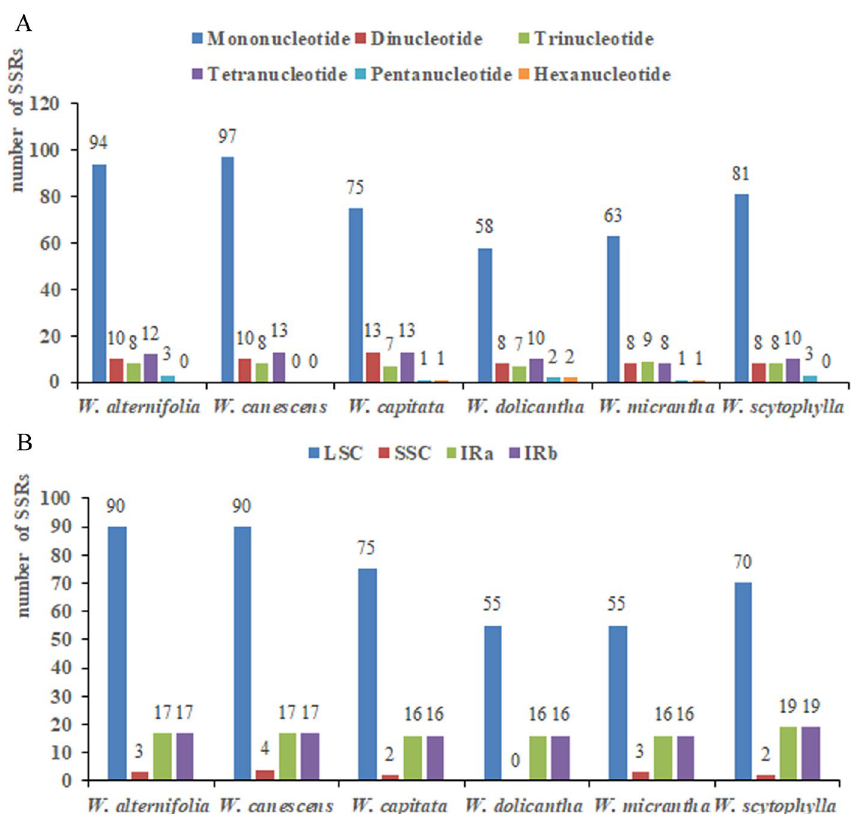
Figure 2. Distribution of small sequence repeats (SSRs) in the plastomes of six accessions of Wikstroemia . ( A ) Number of different SSR types detected in the plastomes of six species of Wikstroemia ; ( B ) Frequencies of identified SSRs in large single-copy (LSC), small single-copy (SSC) and inverted repeat (IR)